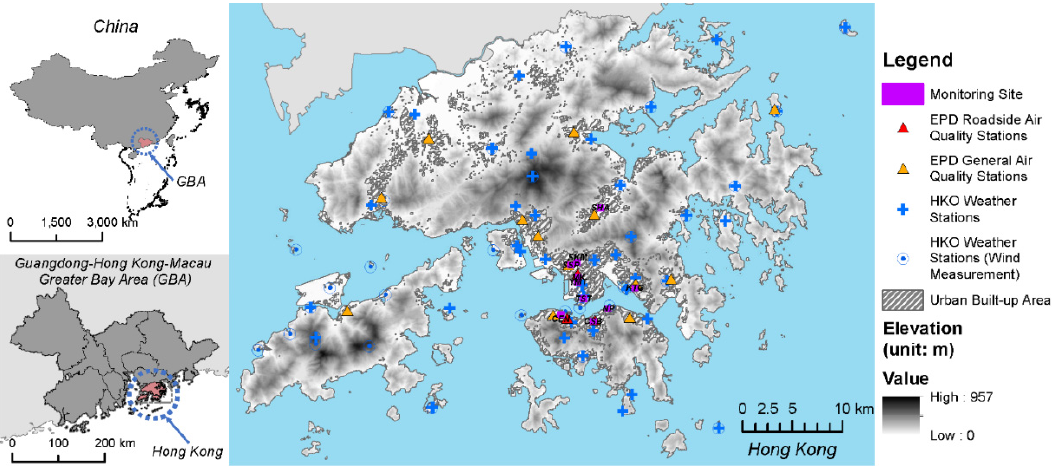
Figure 1. The air quality monitoring network, weather stations for wind measurement, and site selection in this study.